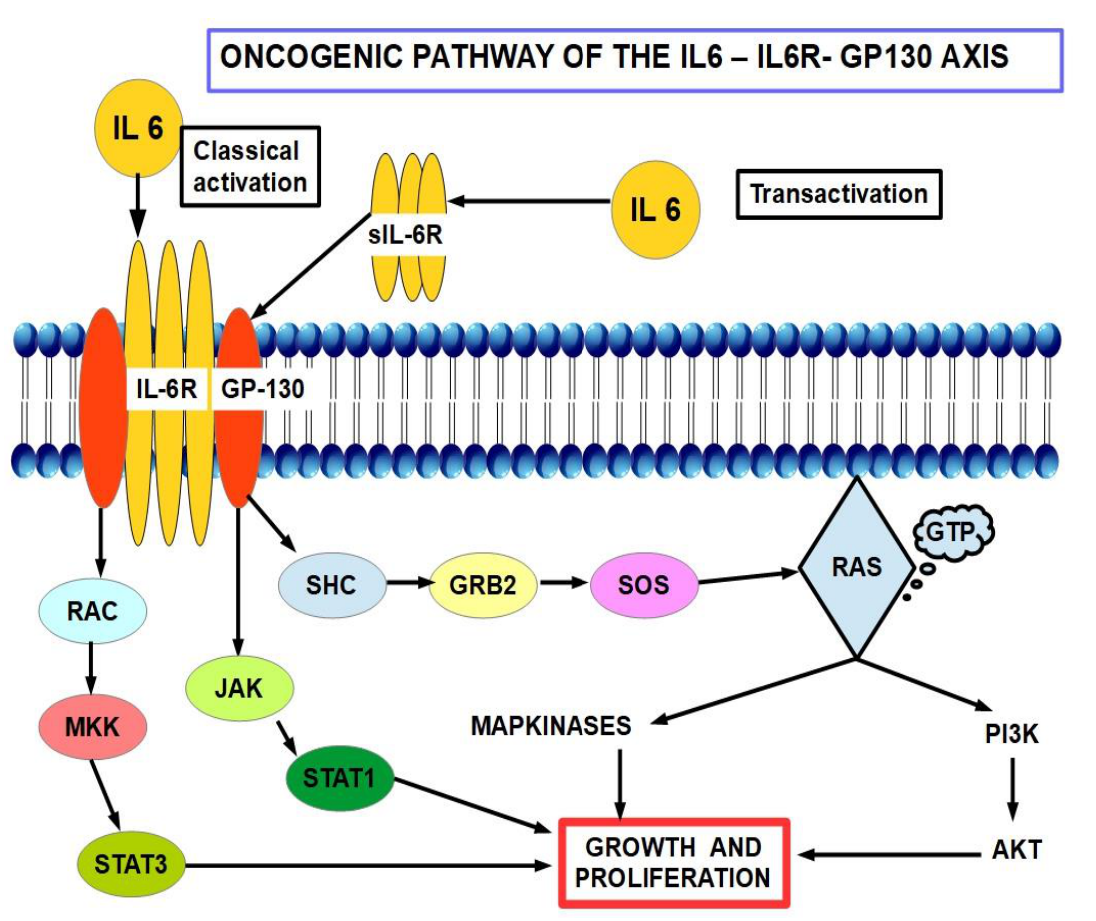
Figure 14. Basedoxifene inhibits GP-130 which is precisely the starting point of IL-6signaling.